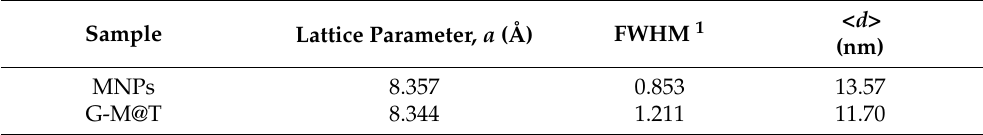
Table 1. Structural parameters obtained by